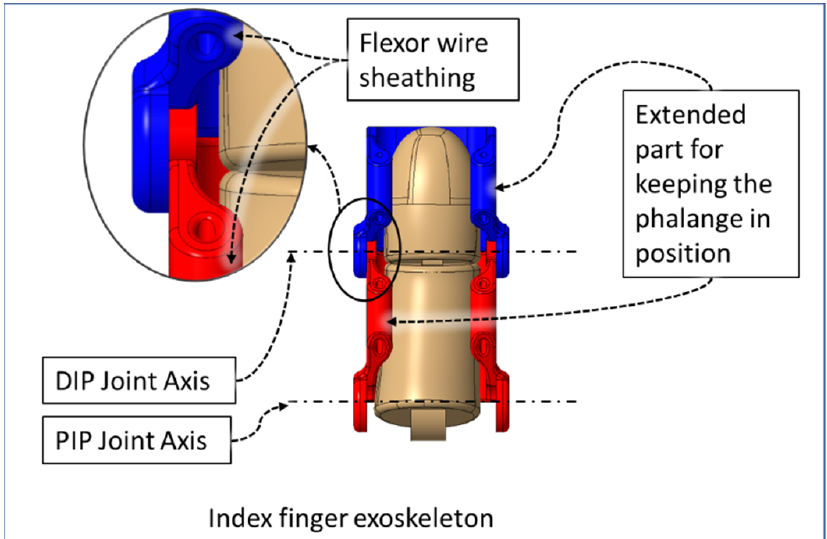
Figure 4. Palmar view of finger exoskeleton segments.